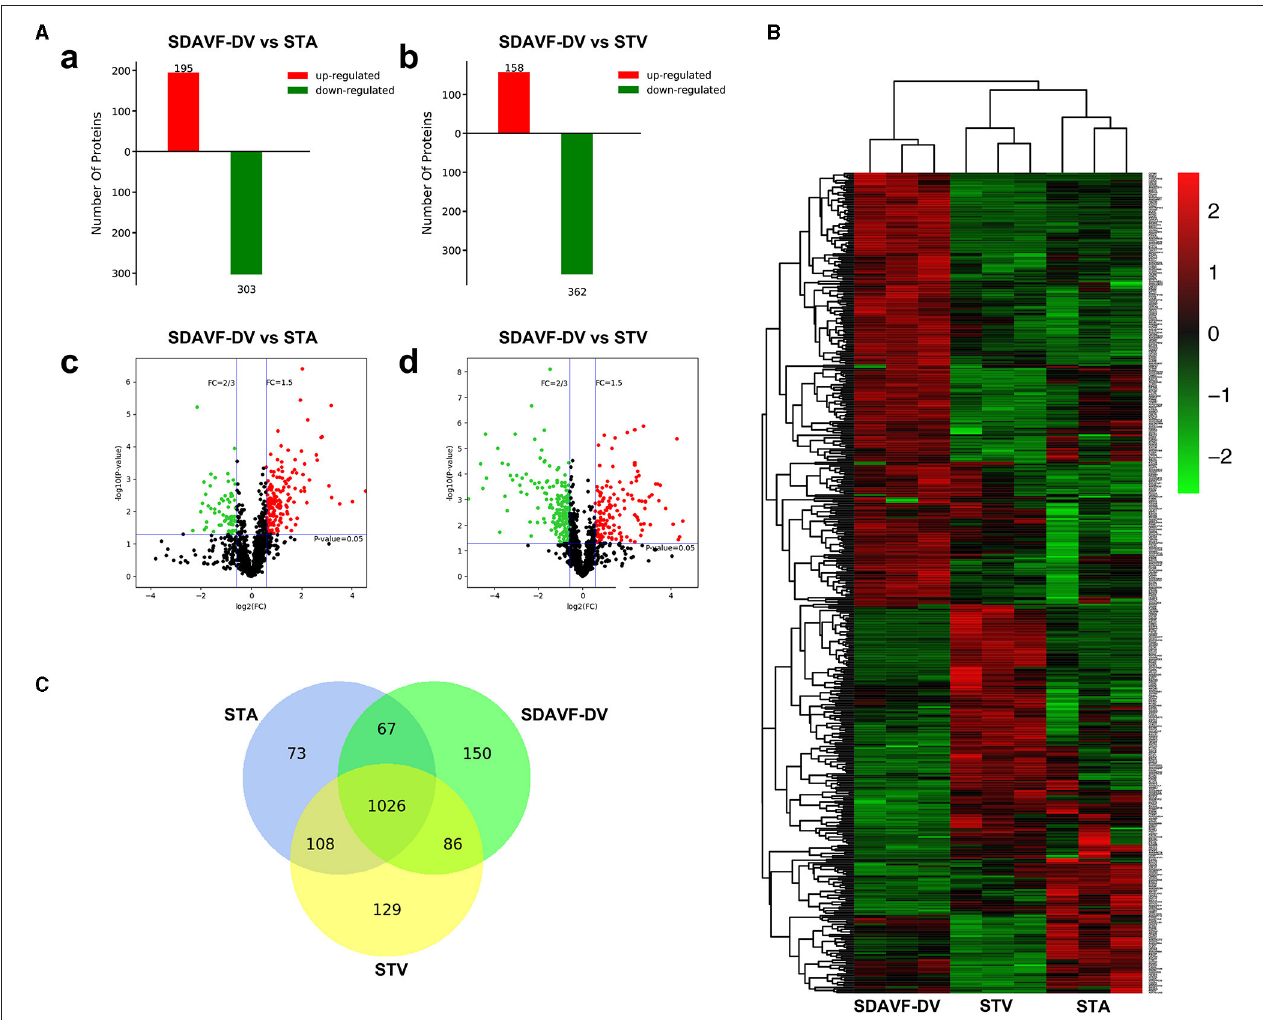
FIGURE 4 | Differentially expressed proteins identified by label-free quantitative proteomics. (A) Significant differences in protein levels in the SDAVF-DV compared with the STA (a) and STV (b). Volcano plot showing protein changes in the SDAVF-DV compared with the STA (c) and STV (d). (B) Heatmap of 480 proteins expressed in the SDAVF-DV, STA and STV. (C) Venn diagram showing overlap of protein expression.